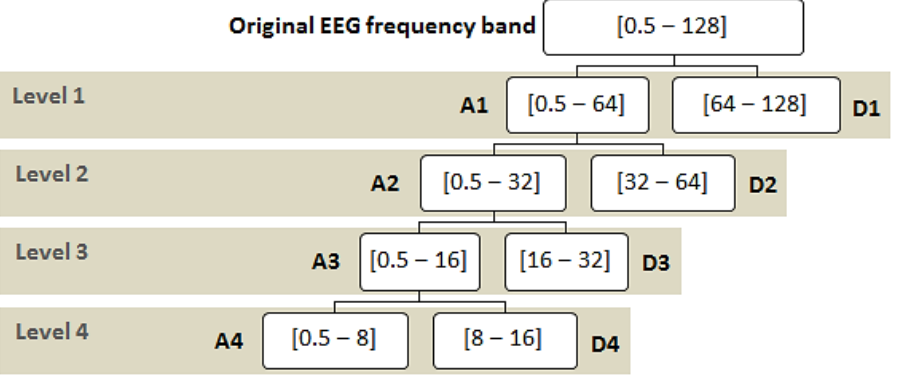
Figure 3. Proposed wavelet decomposition tree (db4).